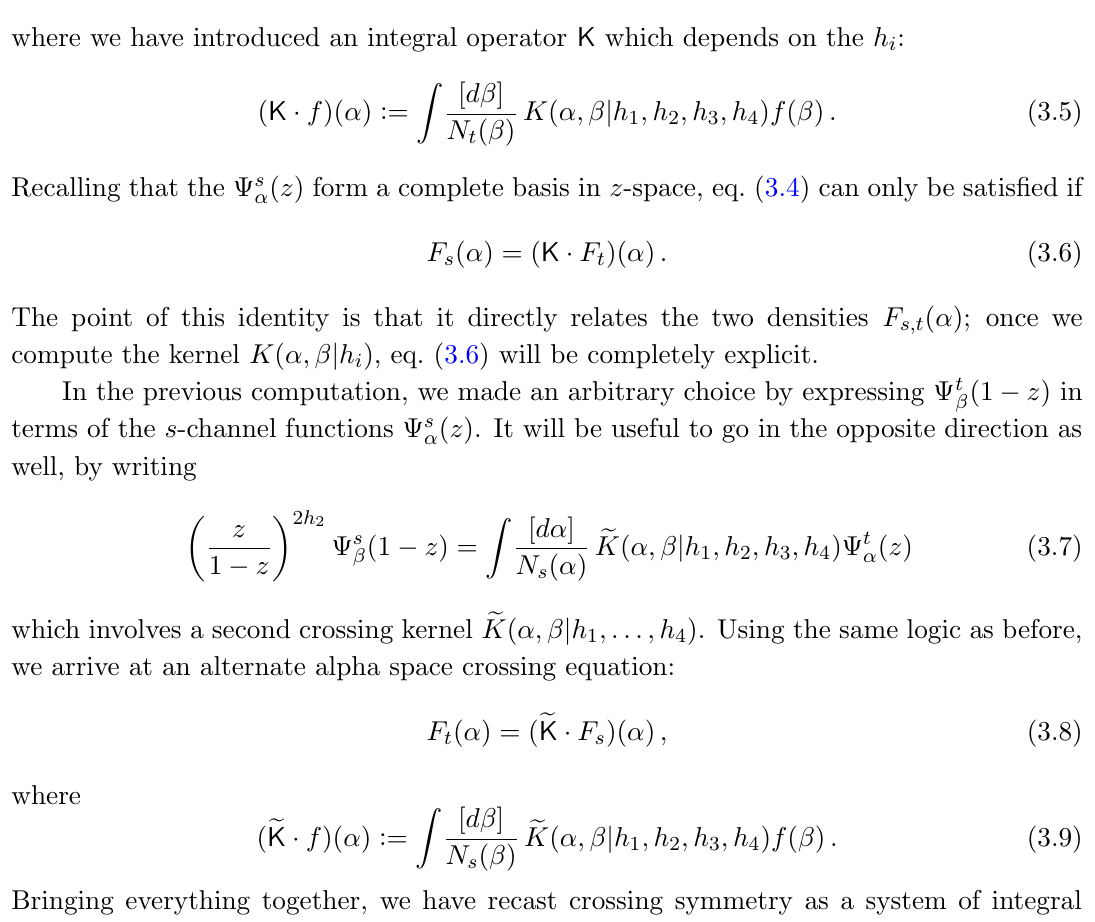
h 1 ; h 2 ; h 3 ; h 4 j